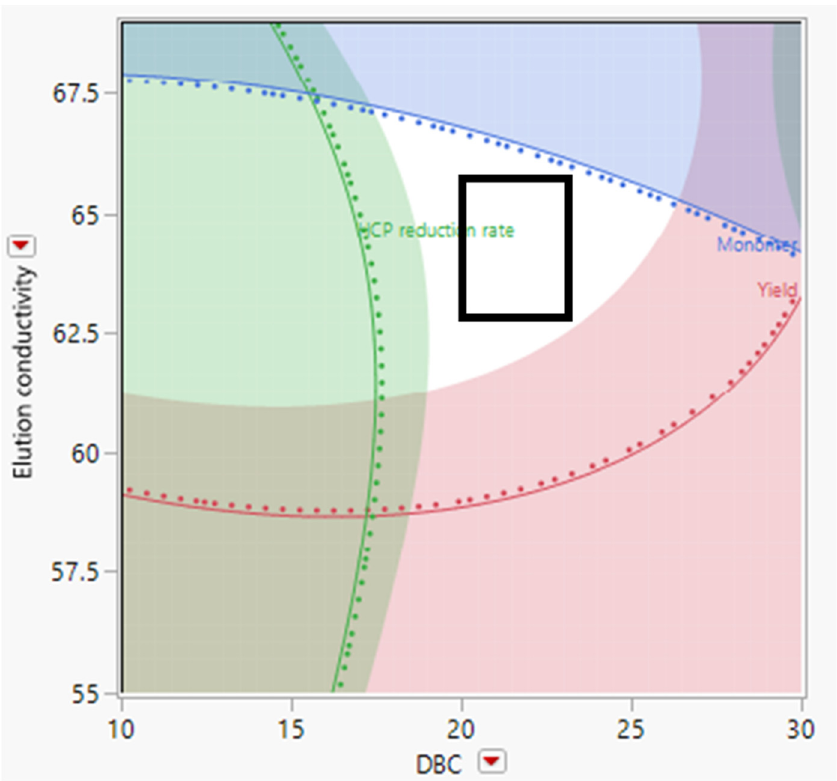
Figure 7. Contour profiler analysis utilizing models obtained from DoE evaluation for cation exchange chromatography for resolution of Fc-fusion protein. The black border is the process range for CEX operation.